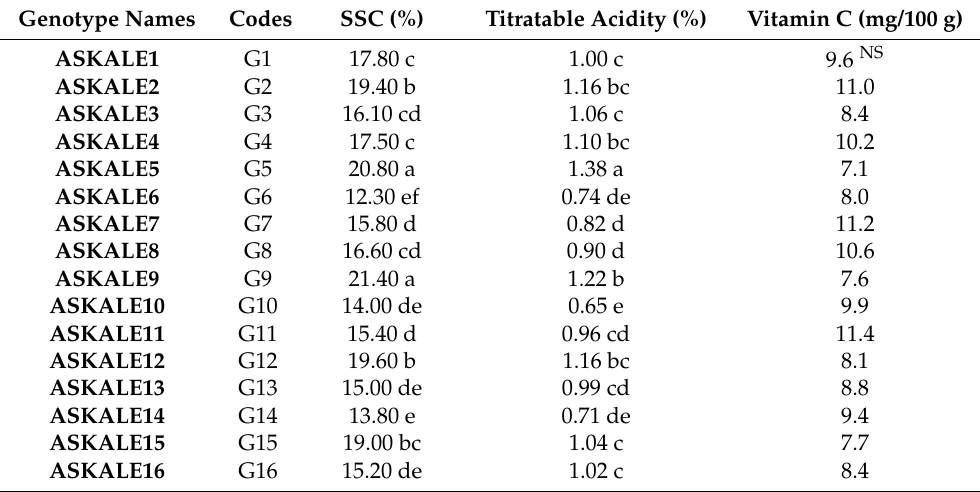
Table 2. Biochemical characteristics of Pyrus elaeagrifolia Pall. subsp. elaeagrifolia genotypes.